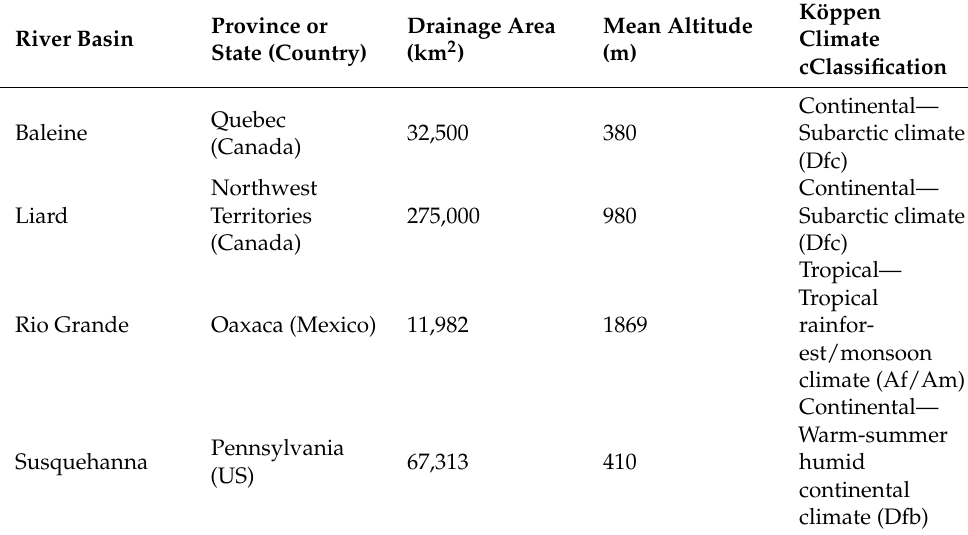
Table 4. General characteristics of the four NA